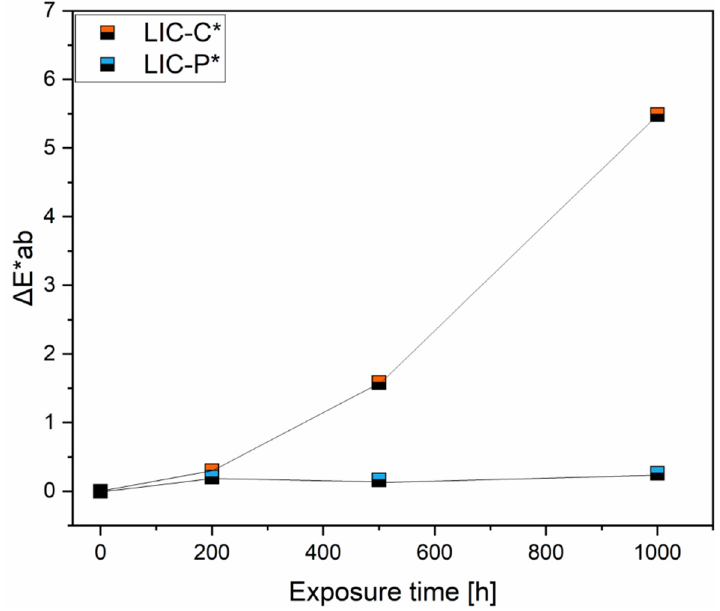
Figure 16. Comparison of colour changes for LIC-C* and LIC-P*coatings at different exposure times to UV irradiation.